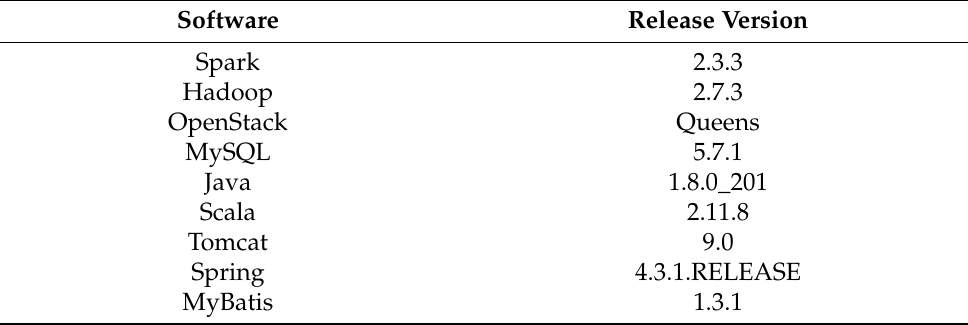
Table 1. Software description of experimental